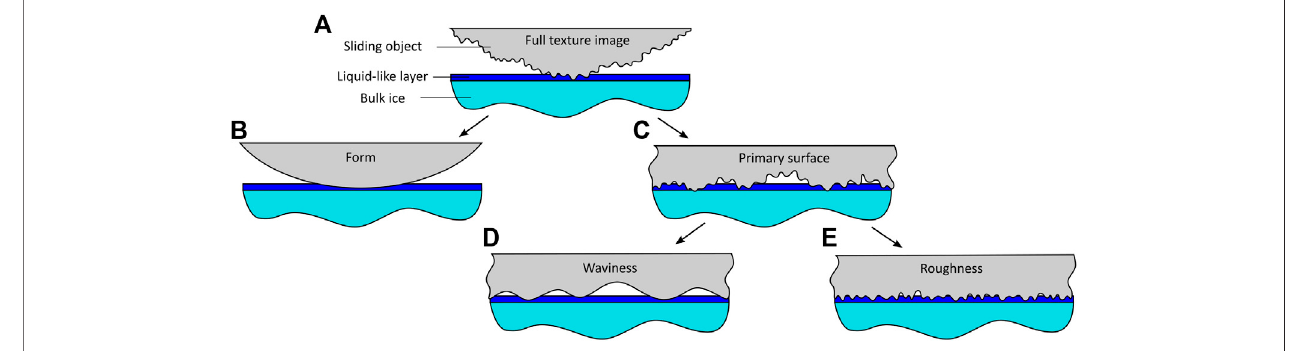
FIGURE2 | Schematic representation ofan interaction between asolid surfaceand ice: (A) fulltexture, (B) form, (C) primary surface, (D) waviness, (E) roughness.